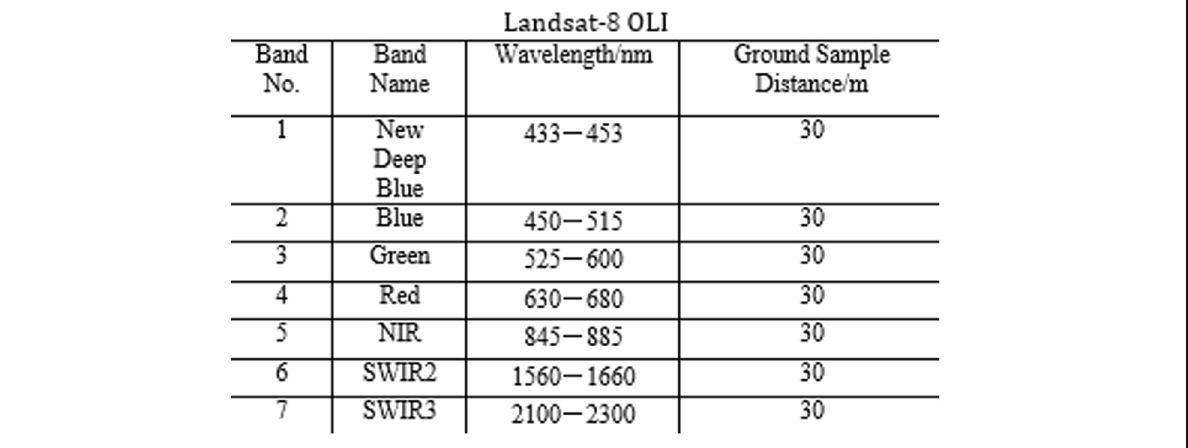
Fig. 2 The image of normal